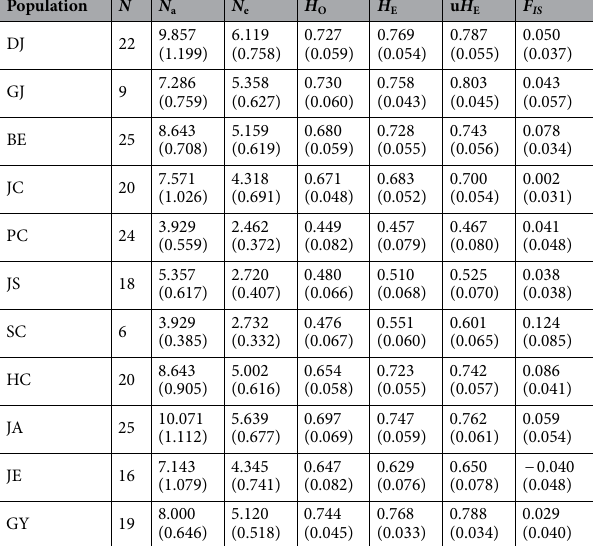
Table 2. Summary statistics of 11 Karsenia koreana populations throughout South Korea based on microsatellite data. Population codes follow Table 1. The value for each statistic is followed by the standard error in parentheses. Abbreviations: Sample size ( N ), number of alleles ( N a ), effective number of alleles ( N e ), observed heterozygosity ( H O ), expected heterozygosity ( H E ), unbiased expected heterozygosity (u H E ) and fixation index ( F IS